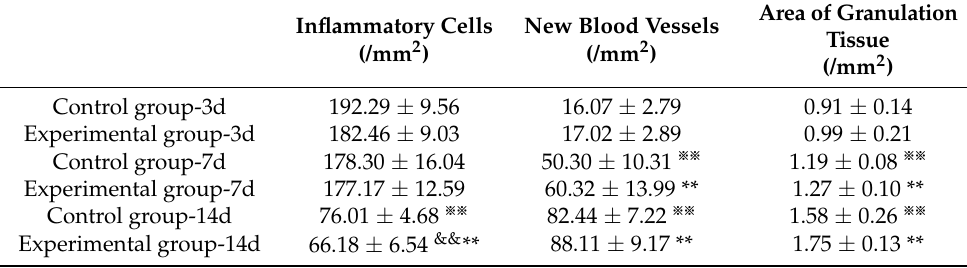
Table 4. The number of inflammatory cells and new blood vessels, and the area of granulation